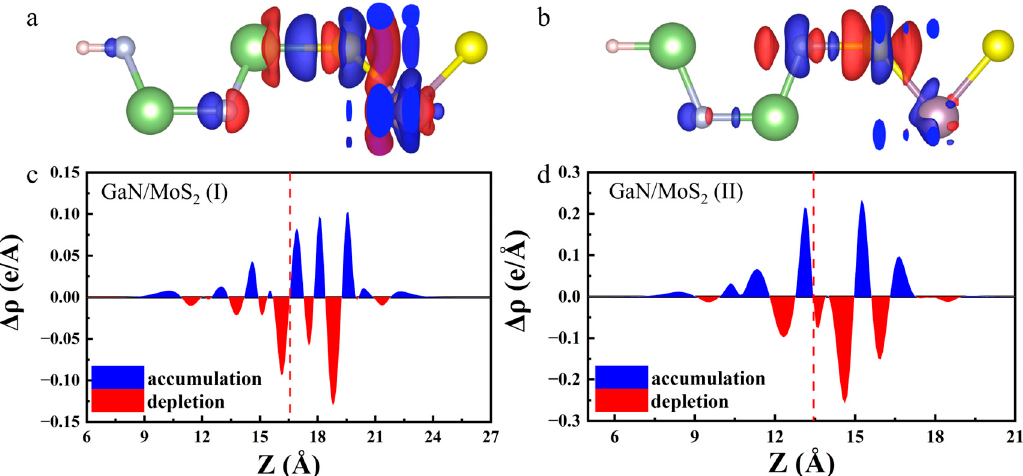
Figure 5. Plane-averaged charge density differences of ( a ) and ( c ) GaN/MoS 2 (I), ( b ) and ( d ) GaN/MoS 2 (II) heterostructures in 3D spatial distributions and along the z − direction, respectively. In ( c ) and ( d ), the red dashed lines represent the GaN/MoS 2 interface boundaries. GaN and MoS 2 correspond to the left and right sides of the interface boundaries, respectively.